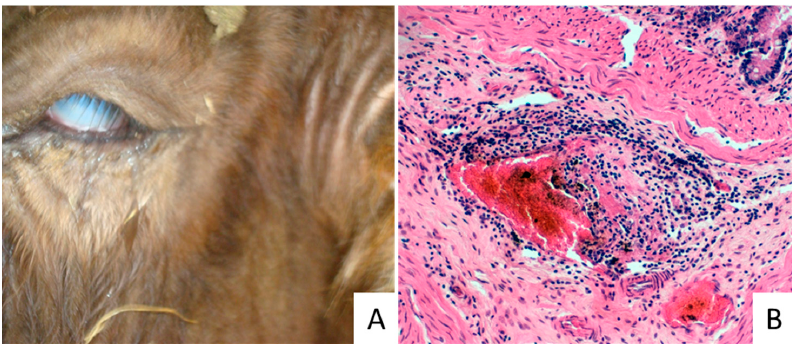
Figure 1. Calf affected by MCF showing keratoconjunctivitis with corneal edema ( A ). Microscopic aspects of intestine in a MCF affected calf. Representative microphotograph of the necrosis affecting a vessel, 20× objective ( B ).